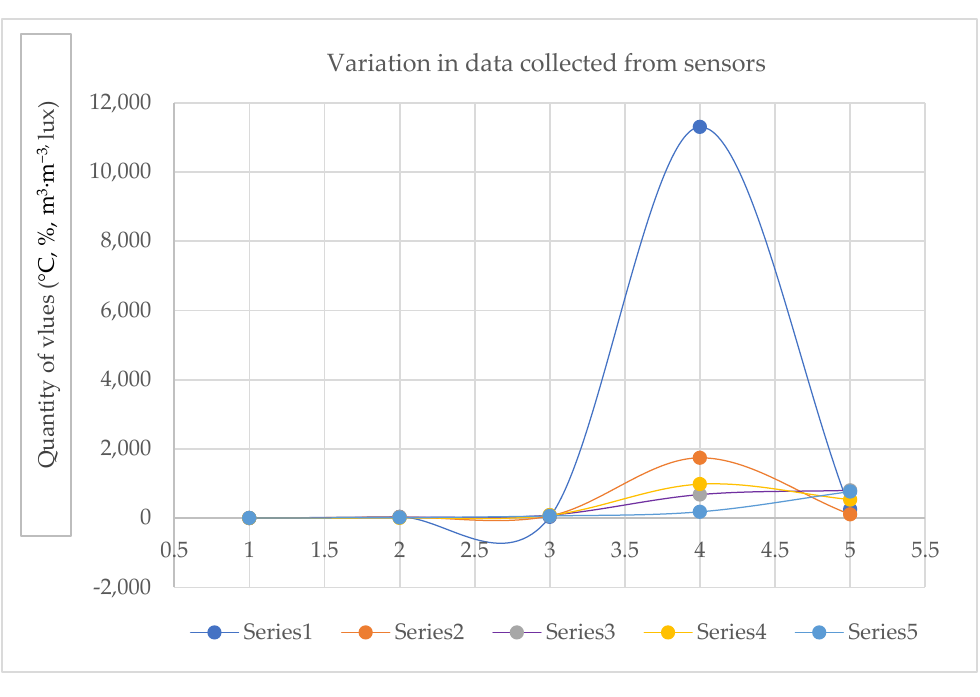
Figure 10. Sensor’s data with variation. Table 9. Calibration of sensor data for fuzzy logic decision making.